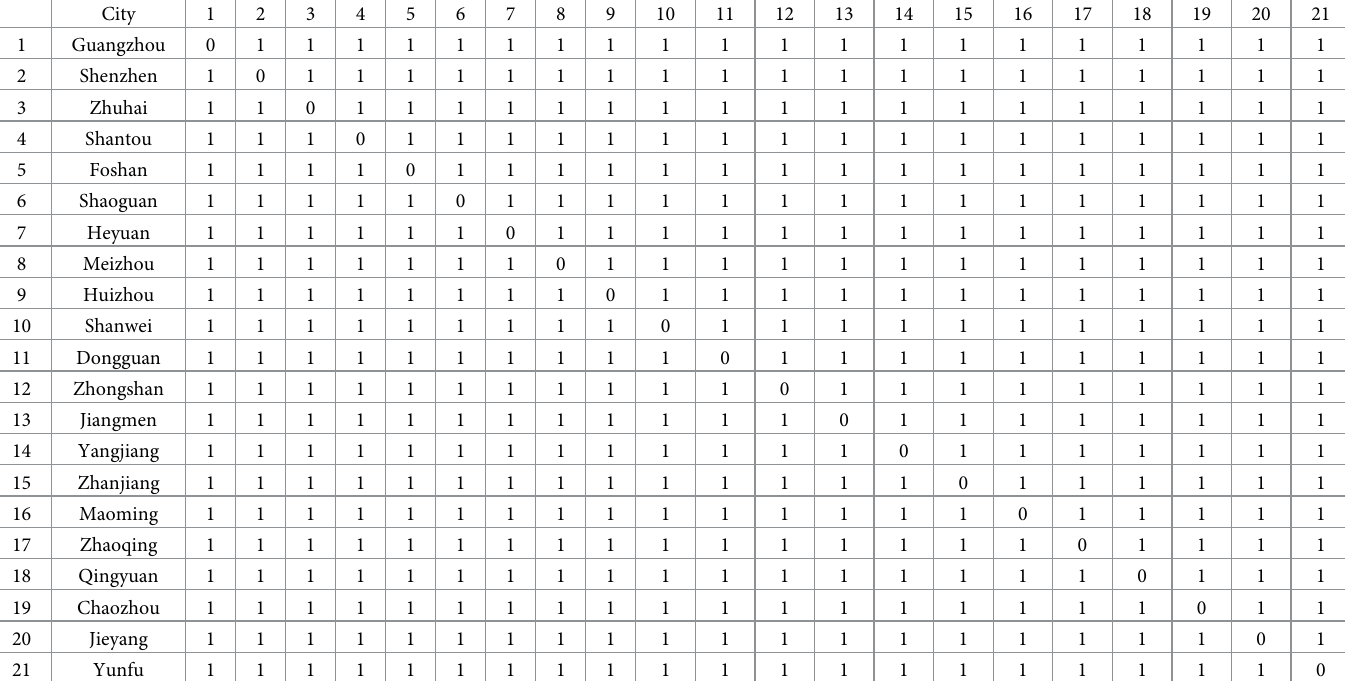
Table 6. Reachability matrix of the spatial correlation